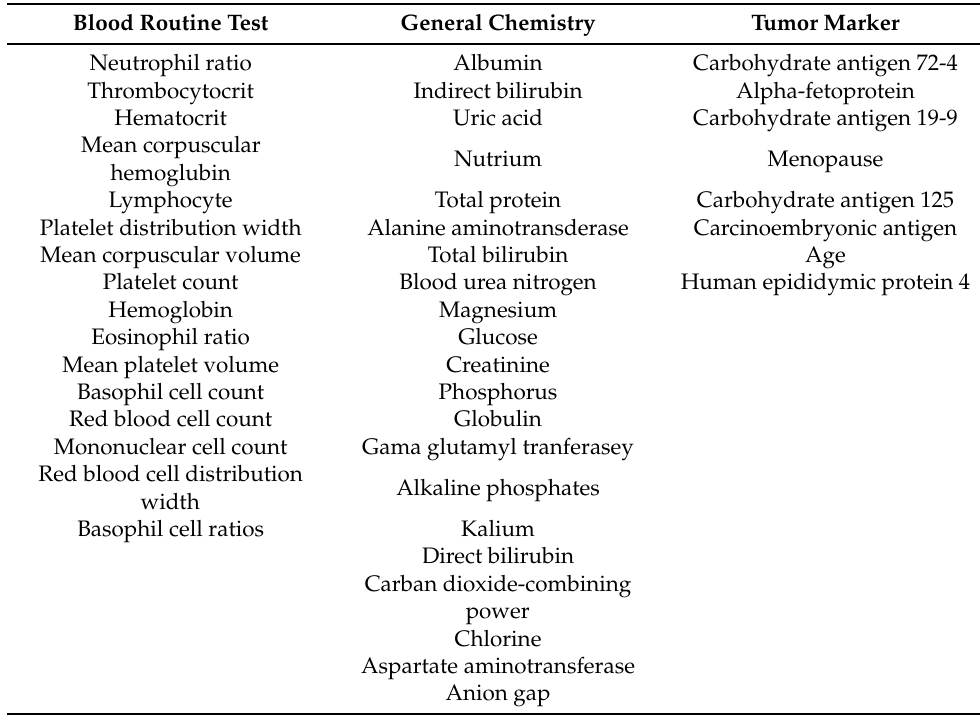
Table 1. The attribute list for different subgroups of the dataset.